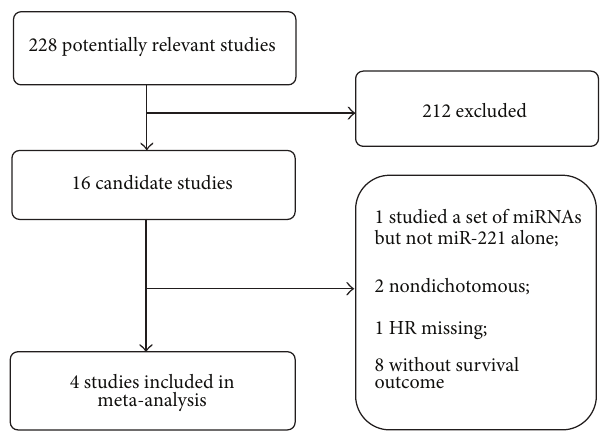
Figure 1: Flow diagram of search